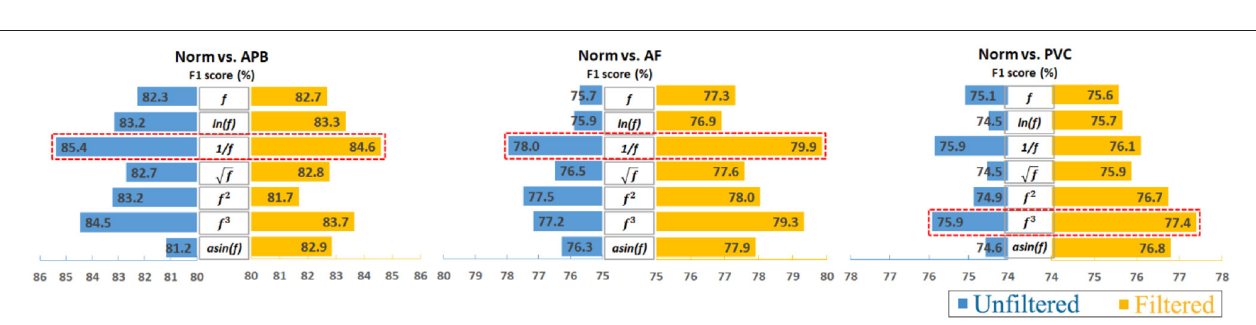
FIGURE 4 | Overall impact of data transformations on classifying ECG heartbeats by averaging the unbalanced, RUS, and SMOTE results. Note that the reciprocal is the most consistently effective data